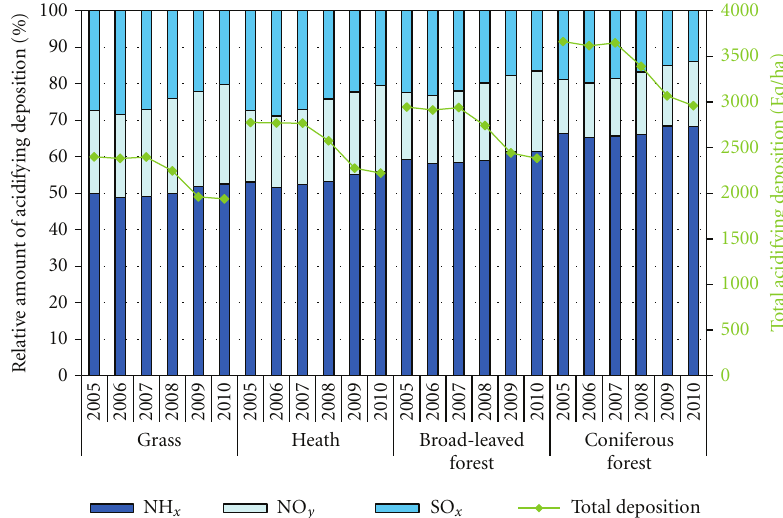
FIGURE 4: Overview of the total deposition from 2005 until 2010 for 4 different vegetation types and the relative amount for each pollutant. The relative amount for NH x and NO y increases, whereas the amount for SO x decreases. Total deposition decreases throughout the 5